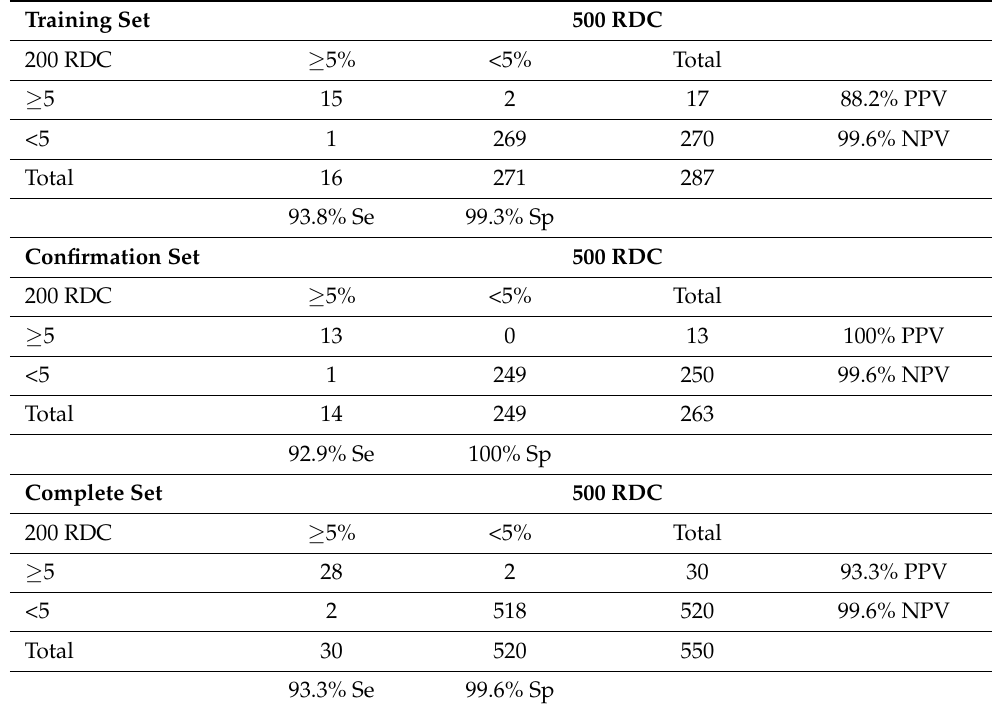
Table 8. Diagnostic performance of 200-cell DCC at the 5% blast